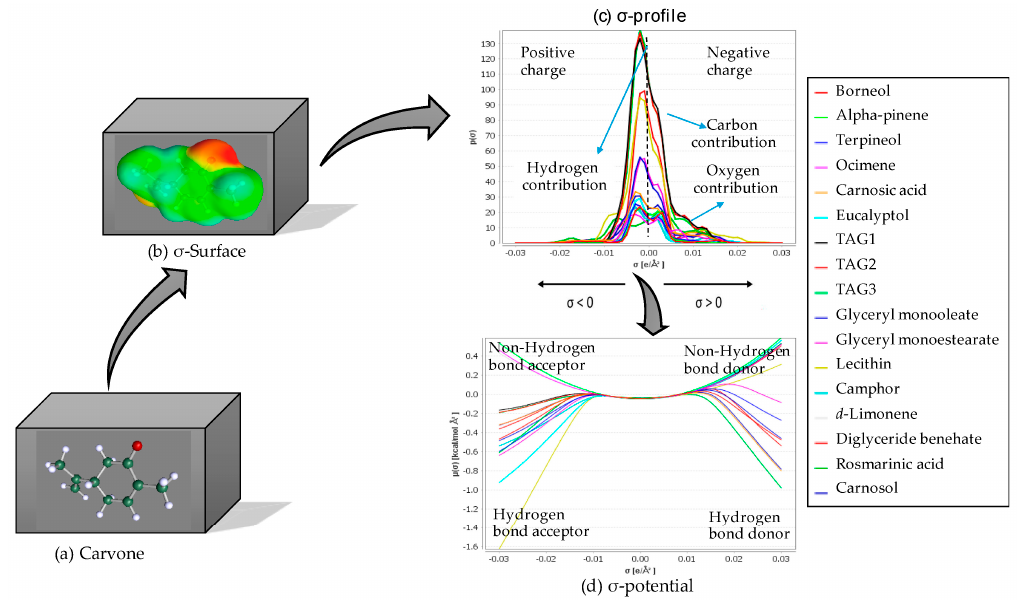
Figure 5. COSMO-RS to select ideal solvent for dissolving a suitable compound. ( a ) Carvone (solute molecule); ( b ) σ -surface; ( c ) energies of local surface interactions between σ -profiles of carvone and solvents; ( d ) σ -potentials of carvone and solvents.